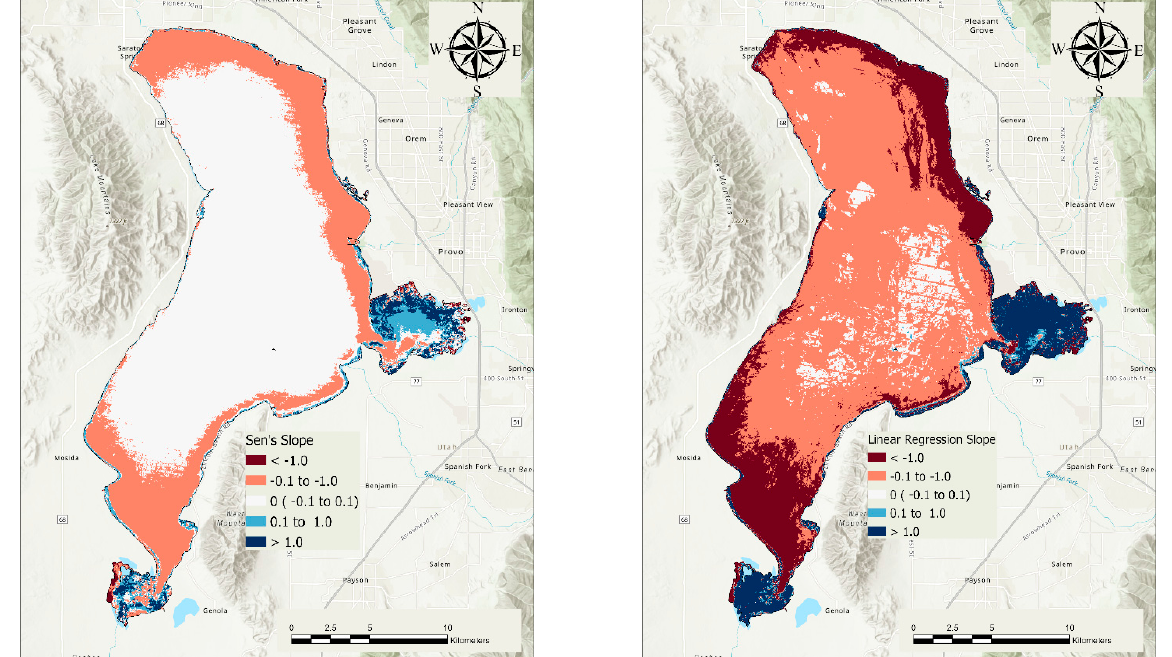
Figure 11. Maps showing the slope of the chl-a trend computed for individual pixels using Sen’s Slope method ( left panel ) and a fitted linear regression line ( right panel ).